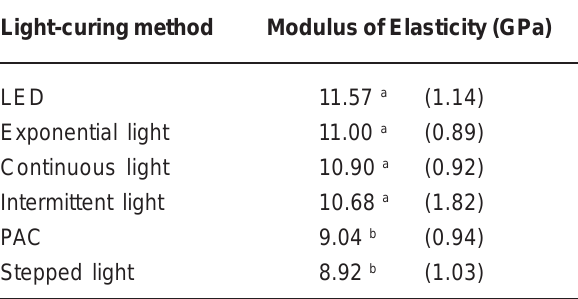
Means followed by different letters are statistically different at 5% by the Tukey test. ( ) Standard Deviation.